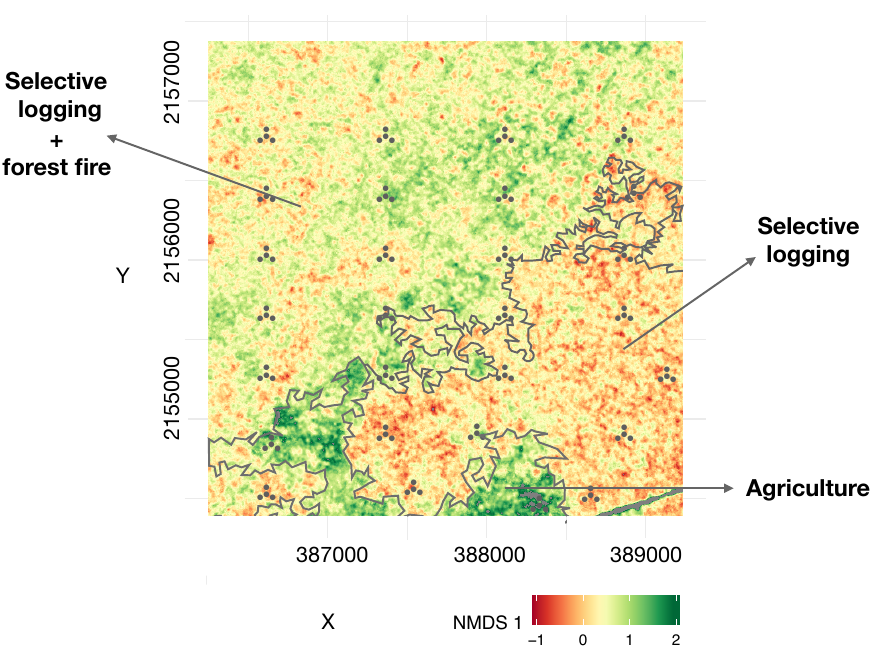
Figure 7. β -diversity predicted values, plots are gray dots, and disturbance histories are labeled. Map proyected in UTM16